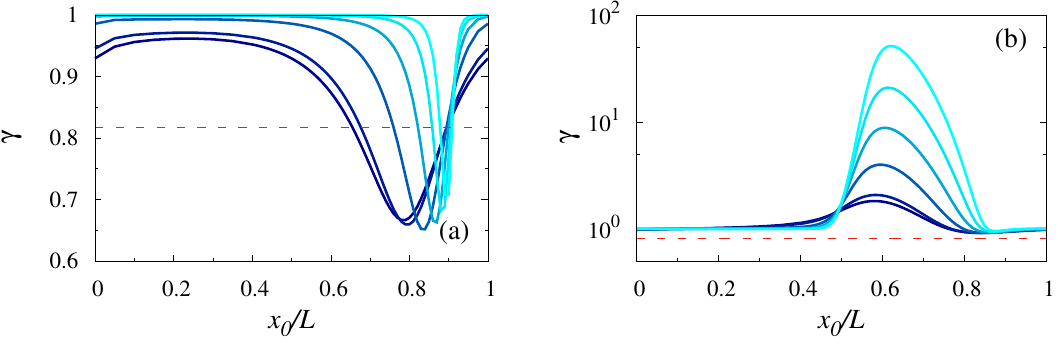
Figure 3. Coefficient of variation γ of the FPTD as a function of x 0 / L for x = x 0 (panel a ) and x = x 0 + L /2 (panel b ) for N = 5,10,30,50,70, and 90 (with lighter colors corresponding to larger values of N ) with L 1 = L /2 and h 0 / L = 0.25 and h 1 / h 0 = 0.8. The channel geometry is the same as in Figure 2. The horizontal dashed line in both panels represents the value of γ for a constant section channel (recall that for this case γ was independent of the polymer length N